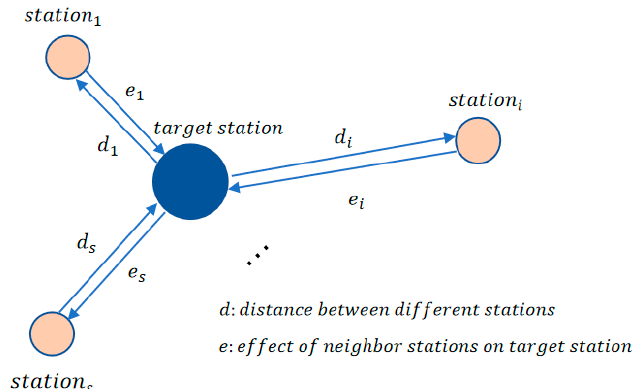
Figure 4. Spatial e ff ect of neighbors.